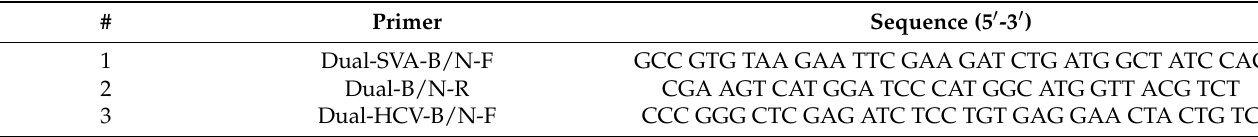
Table 2. Primers used for construction of bicistronic reporter plasmids of SVA. Primer Sequence (5 (cid:48) -3 (cid:48)